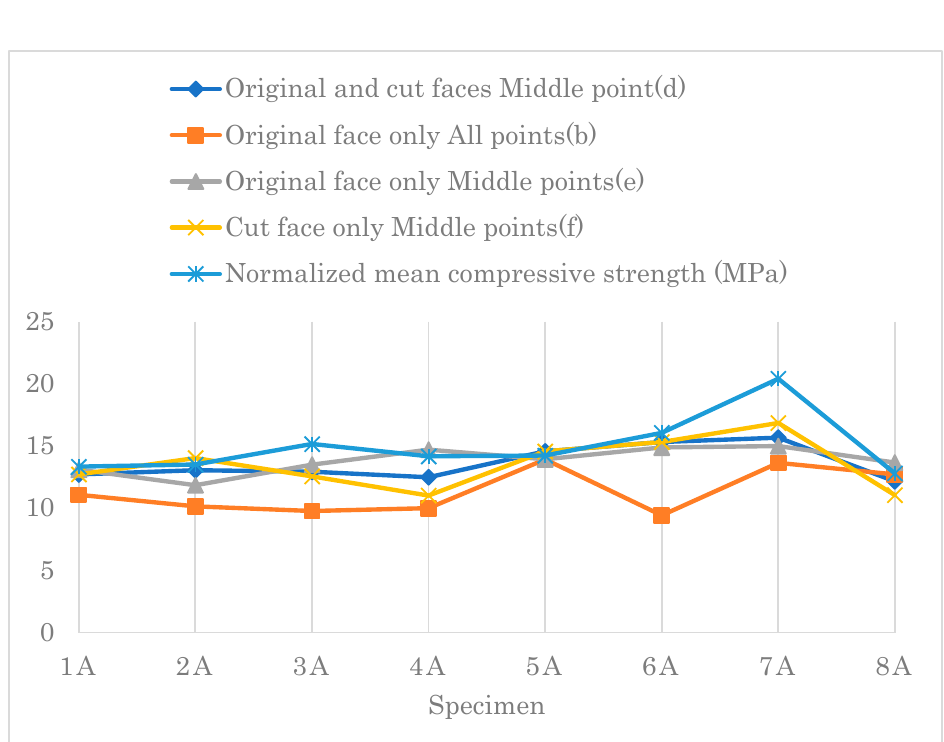
Figure 9. Multiple compressive values by specimen.